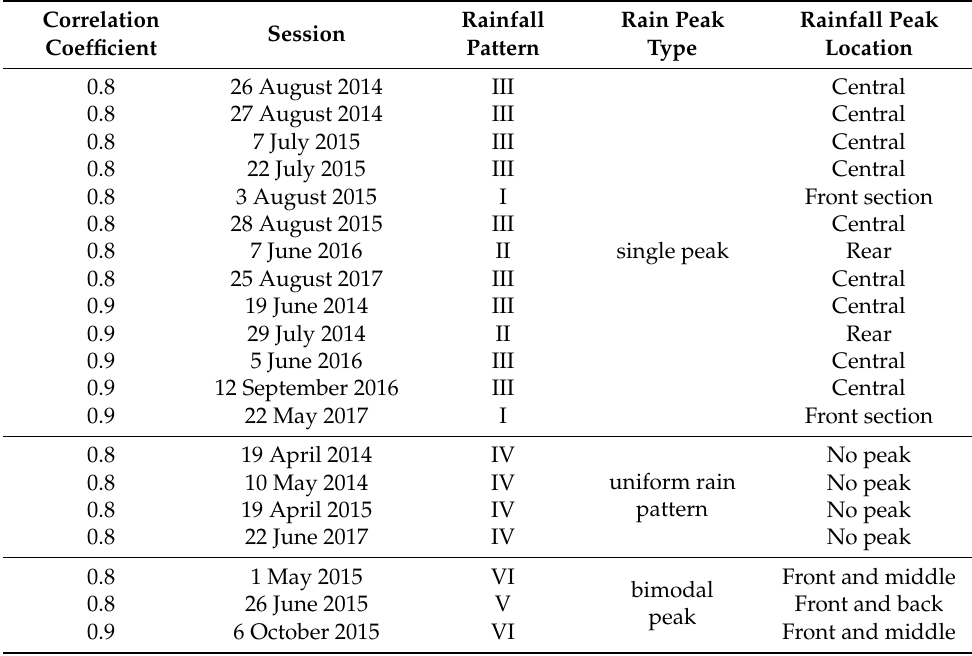
Table 4. Rainfall pattern identified results of Weibo.